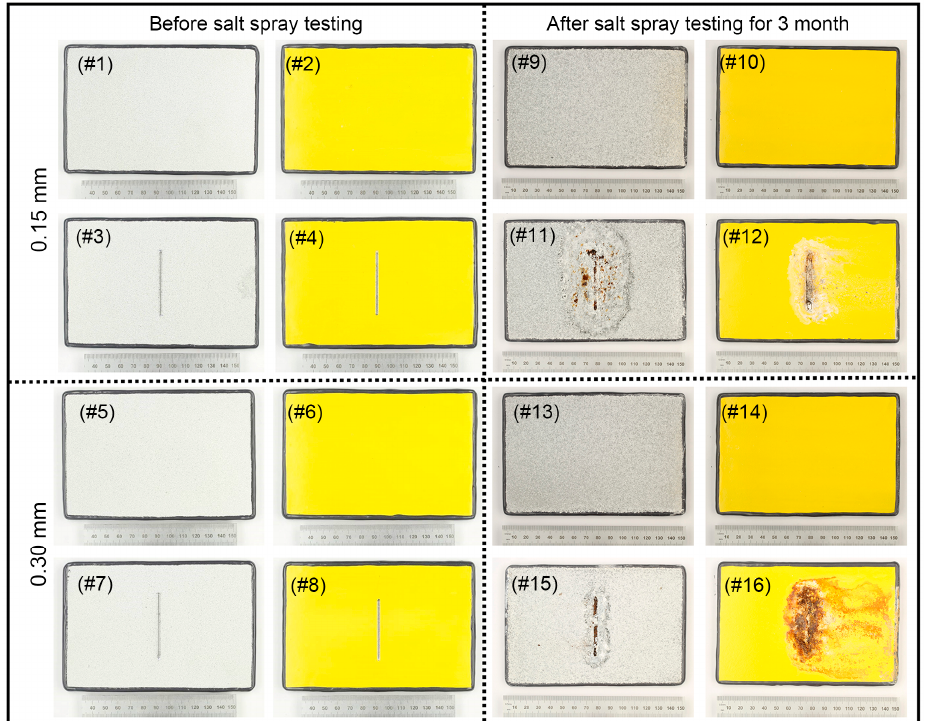
Figure 2. Macro morphology of Al coating samples before and three months after salt spray test.